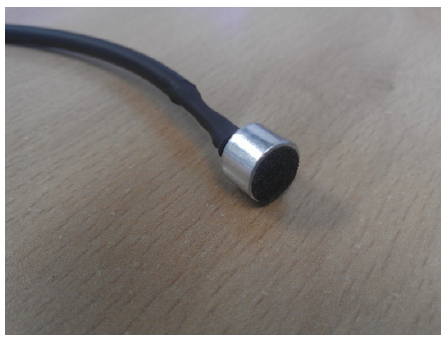
Figure 3. MCE-100